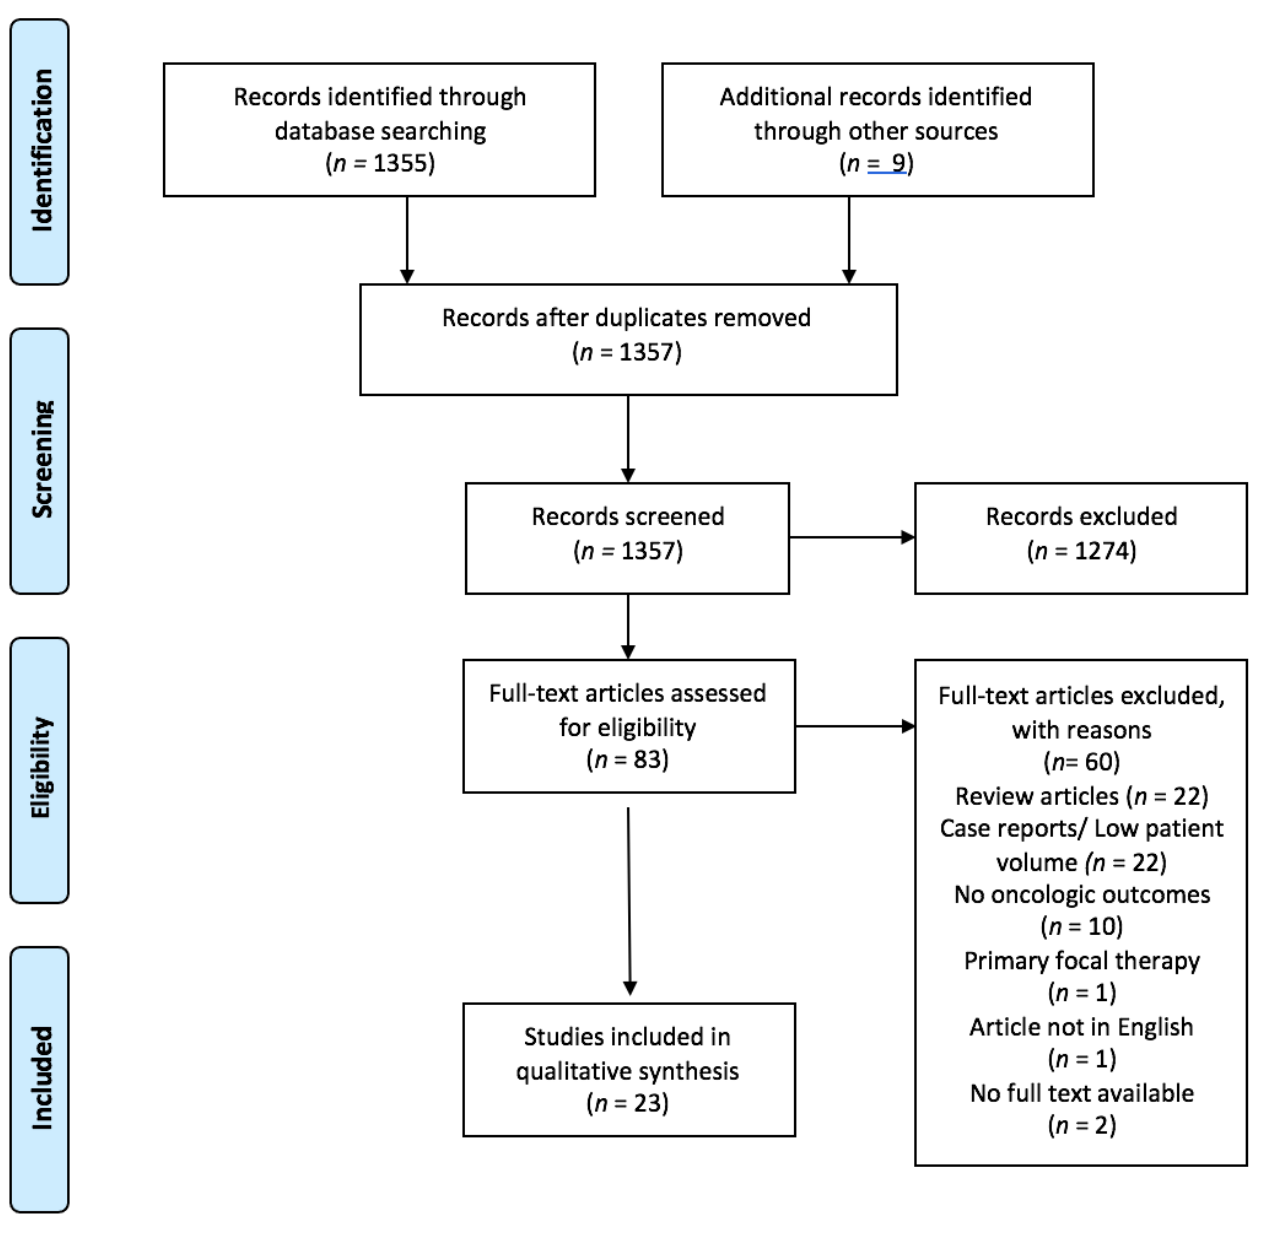
Figure 1. PRISMA flow diagram.